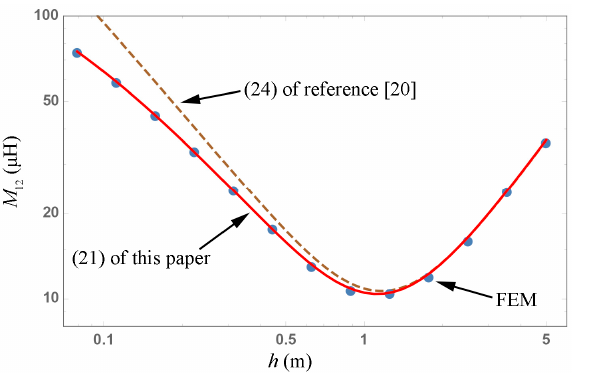
Figure 10. Pitch length ( h ) dependence of the mutual inductance ( M 12 ) of coils with equal